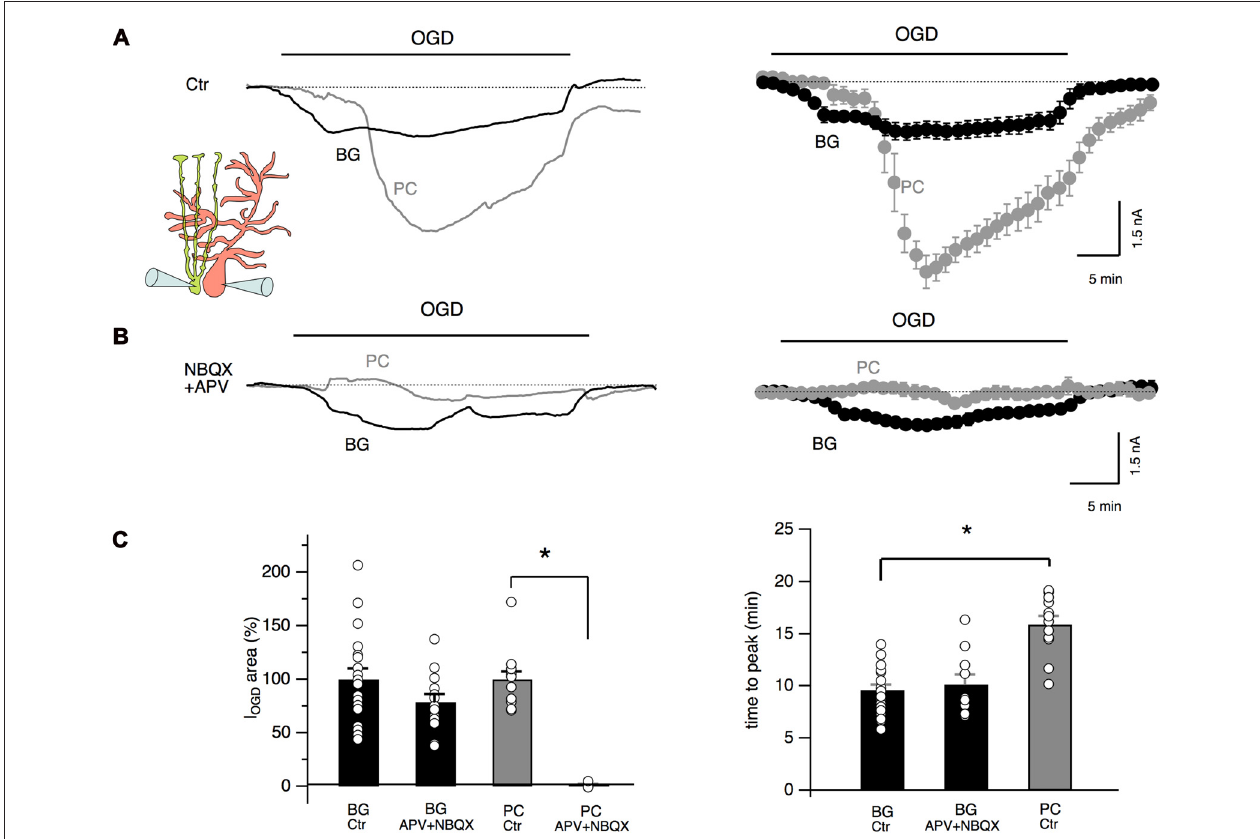
FIGURE 3 | Glutamate differently affects Purkinje neurons and Bergmann glia. (A) Double, simultaneous patch clamp recordings of a Bergmann glial cell and a Purkinje neuron during OGD. Mean traces are shown at the right ( n = 6). Note the difference in current dynamics, amplitude and post-OGD phase in the two cell types. (B) NBQX (25 µ M) and APV (50 µ M) drastically inhibit OGD-induced currents in Purkinje neurons while little effect is observed in I OGD of Bergmann cells ( n = 5). (C) Left: quantification of the electrical charge calculated in control or in the presence of ionotropic glutamate receptor blockers in Bergmann glial